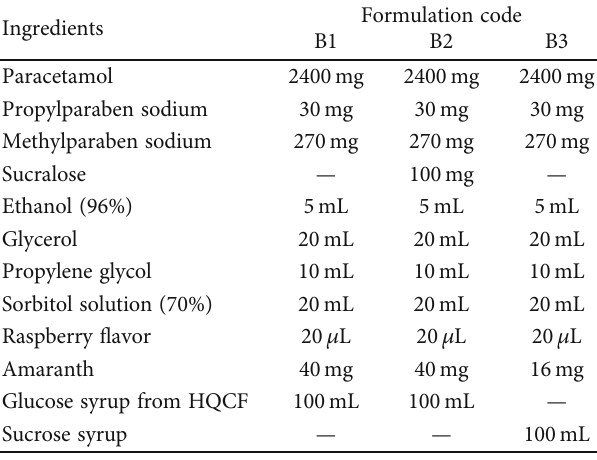
Table 2: Composition of formulated simple linctus.